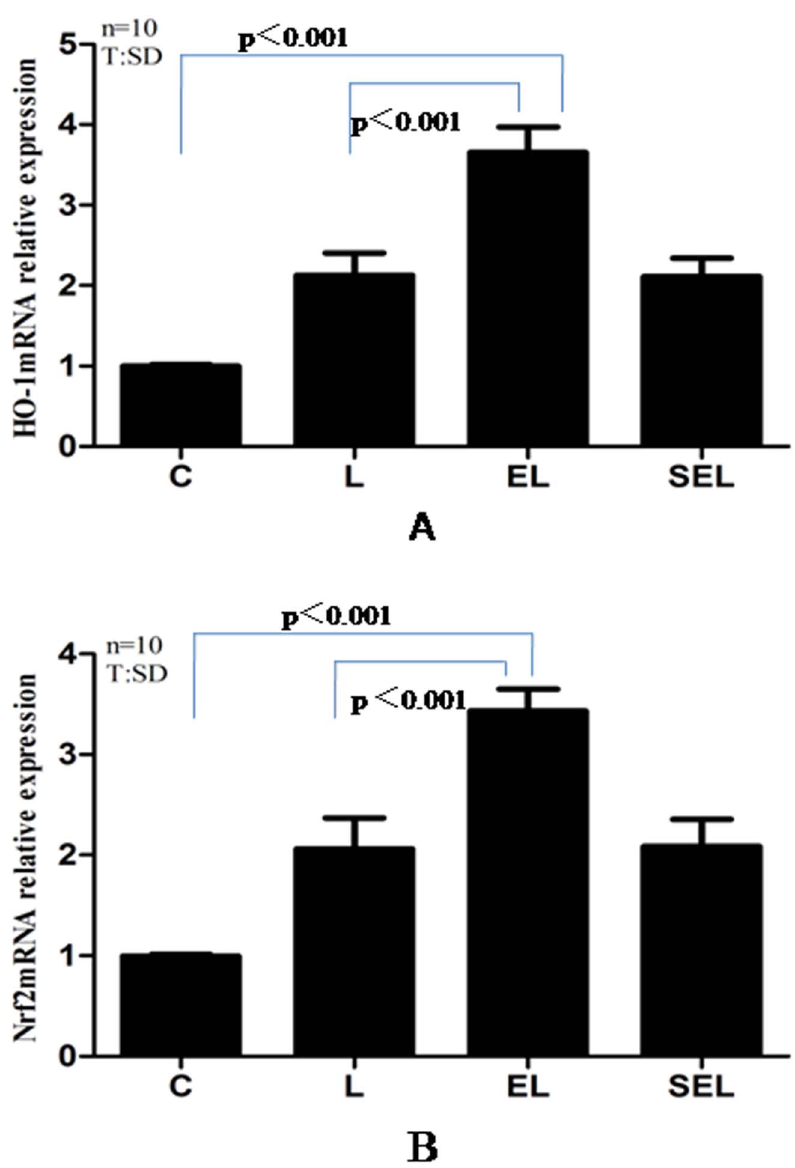
Figure 2. Real-time PCR analysis of HO-1 mRNA (A) and Nrf2 mRNA (B) expressions in the lung tissue of four groups. Data were presented as mean 6 SD. ‘‘C’’ presents group C, ‘‘L’’ presents group LPS, ‘‘EL’’ presents group electroacupuncture + LPS and ‘‘SEL’’ presents group sham electroacupuncture + LPS. The relative expressions of HO-1 mRNA and Nrf2 mRNA in group EL were higher than that in group C and group L ( P , 0.05 ), while no significant differences were found between group SEL and group L in terms of the above mentioned mRNA expressions( P . 0.05 ). Ten control, LPS, EL and SEL experiments were performed for each group.